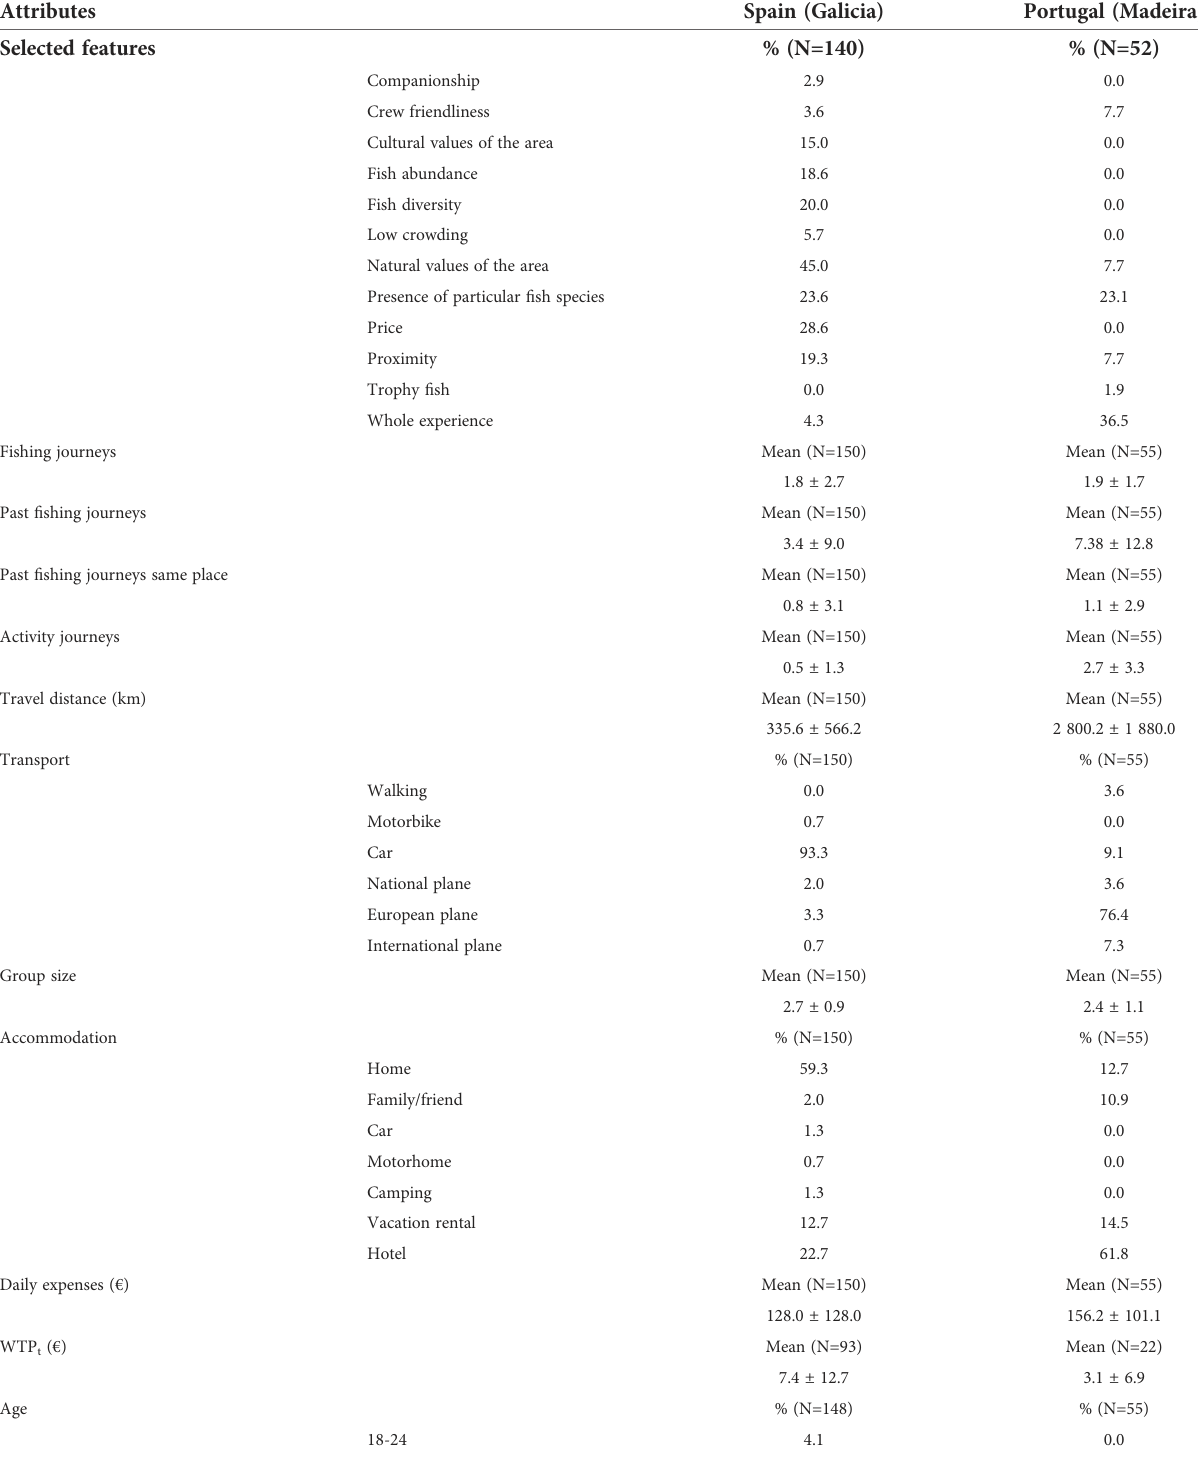
TABLE 3 Descriptive characteristics of the fi shing activity valued by clients of recreational fi shing charter boat companies in Spain (Galicia) and Portugal (Madeira archipelago). Attributes Spain